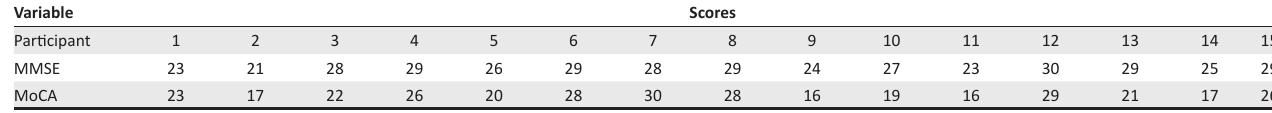
MMSE, Mini-Mental State Examination; MoCA, Montreal Cognitive Assessment Test. TABLE 4: Raw scores obtained with the MMSE and MoCA for participants 16–30. Variable